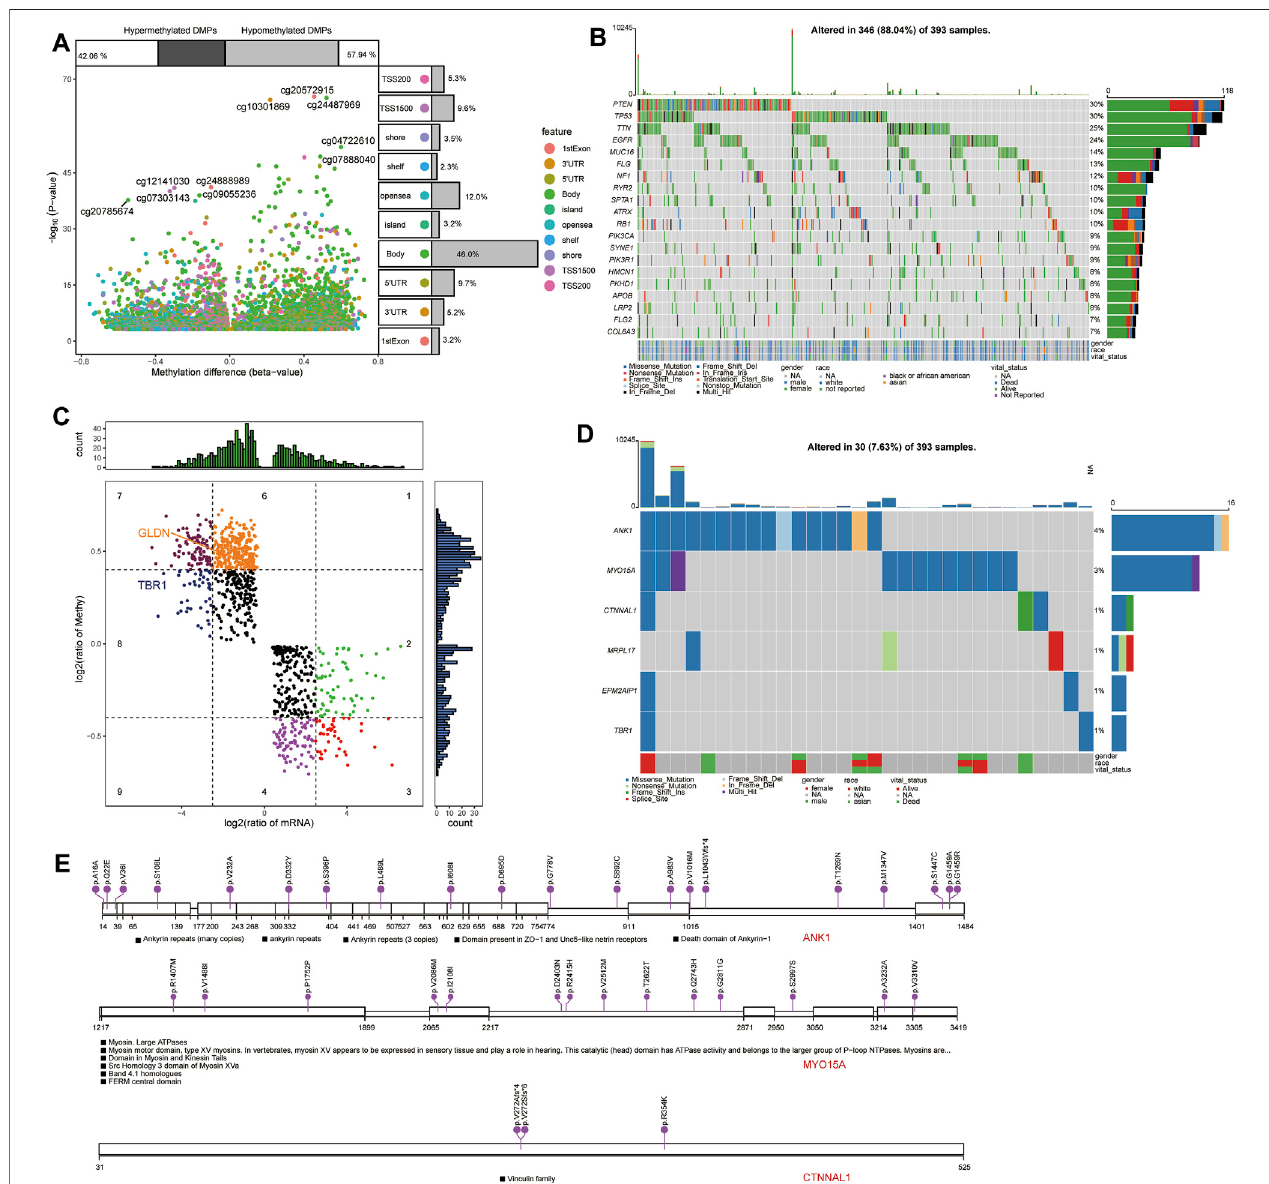
FIGURE 10 | Methylation modi fi cation and mutational landscape of candidate mRNAs. (A) Differentially methylated probes between GBM and controls in TCGA. DMPs, differentially methylated probes. (B) DeltaBeta levels and expression levels of methylation markers. (C) Top 20 somatic mutations in GBM in TCGA. (D) Mutation spectrum in candidate mRNAs in GBM patients. (E) Mutations in the top three candidate mRNAs in